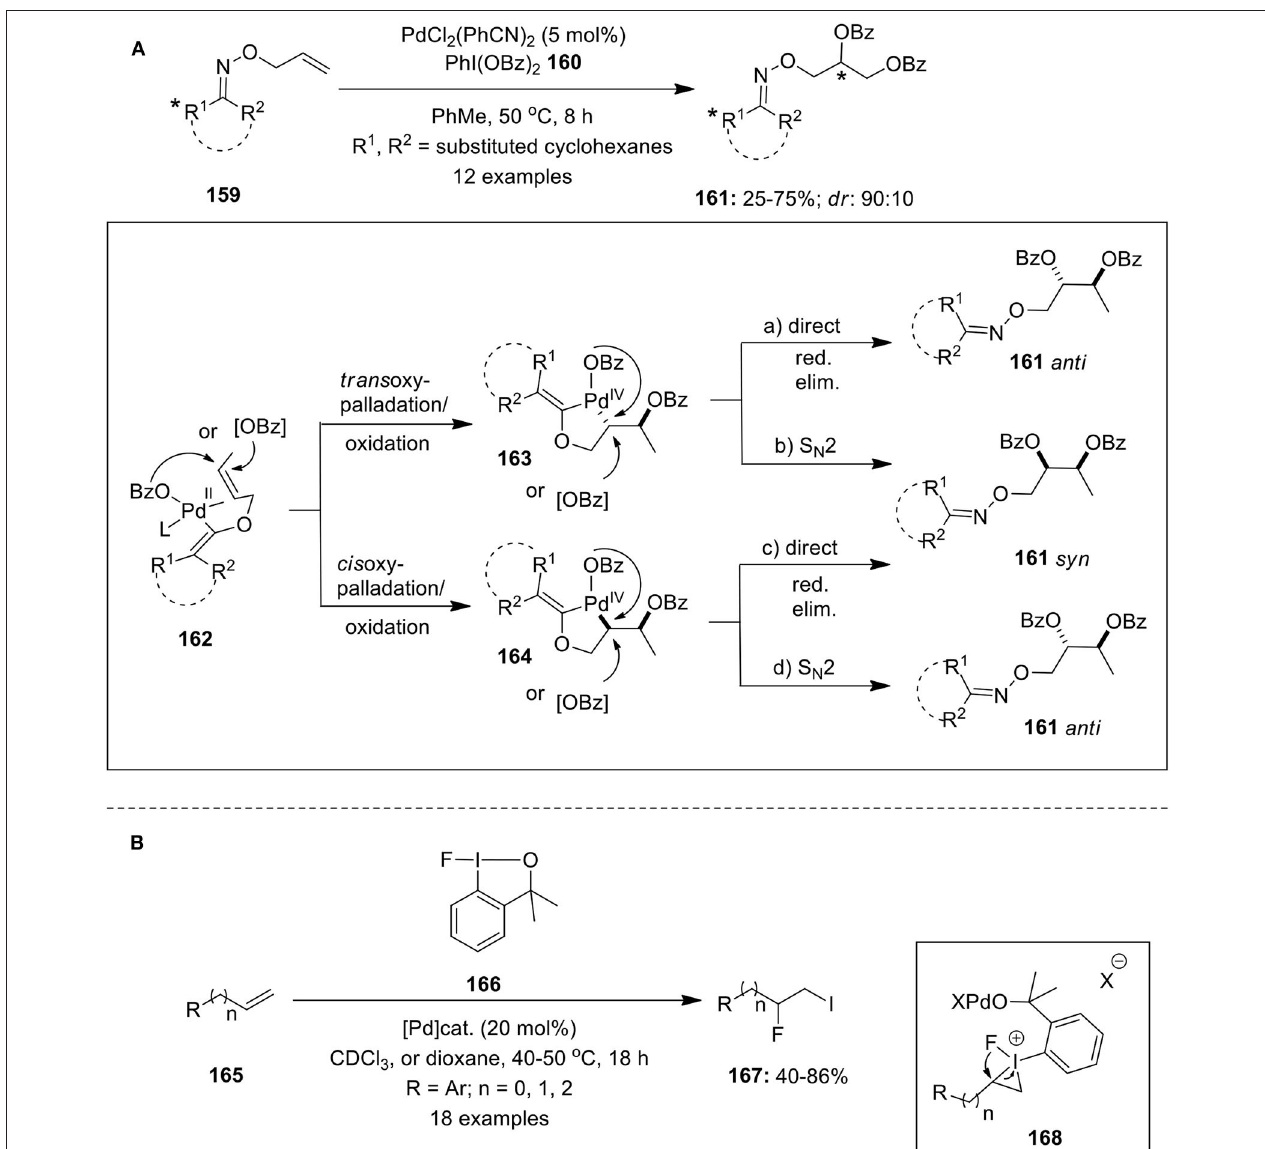
stereochemical aspect of the aminoacetoxylation reaction favoring trans -aminopalladation